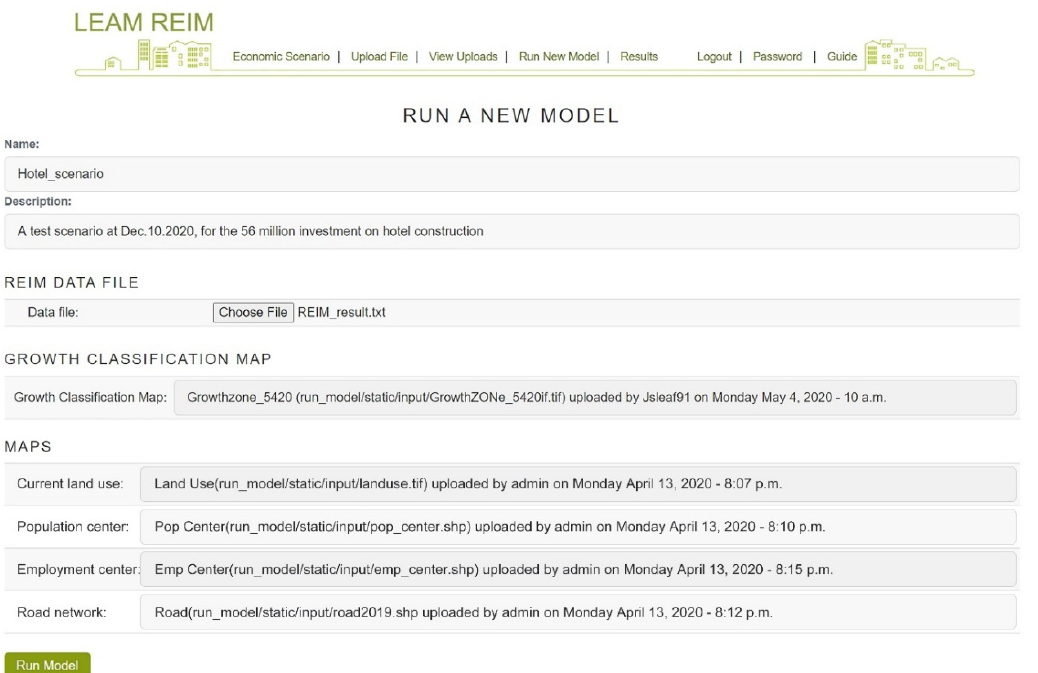
Land 2021 , 10 , x FOR PEER REVIEW 10 of 17